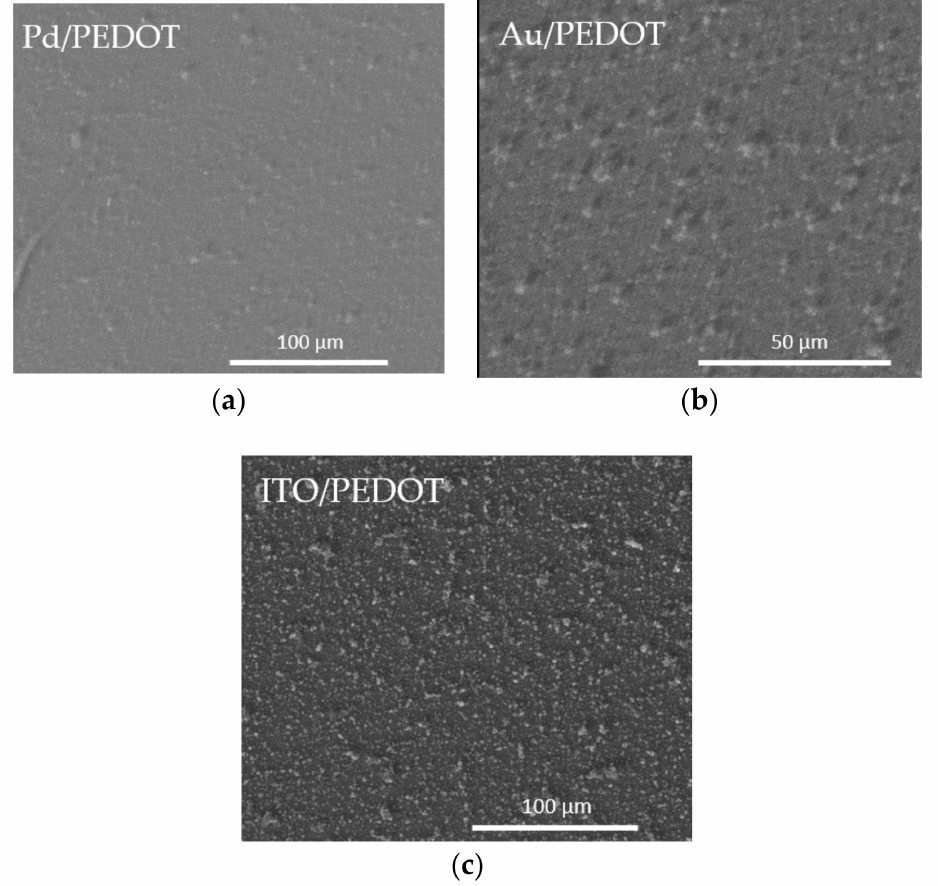
Figure 3. ESEM images of the PEDOT films on ( a ) Pd, ( b ) Au, ( c ) ITO. The morphology appeared rough and dense, with highly visible cluster sites and uniform particle sizes (Figure 3, Figures S1 and S2). The difference between the two metallic substrates (Figure 3a,b) was negligible. On the contrary, the PEDOT films on ITO evidenced a more indented pattern, suggesting a greater contribution from nucleation. This effect can be related to the ITO surface’s higher roughness, with respect to the metal ones. The Raman spectra confirmed the presence of PEDOT in all the samples. As seen from Figure 4a, the bands at 440 cm − 1 , 992 cm − 1 and the broadband at 1240–1270 cm − 1 were assigned to the C–O–C deformation, oxyethylene ring deformation and C α –C α inter-ring stretching, respectively. In particular, the peculiar band at 1427 cm − 1 due to symmetric C α =C β (–O) stretching indicated a high level of conjugation in the structure of PEDOT [46–48]. The visible spectrum of the PEDOT coating on ITO (Figure 4b) showed the characteristic broadband dip in the absorption signal at approximately 400–700 nm, which may be related to the π – π * transitions of thiophene ring